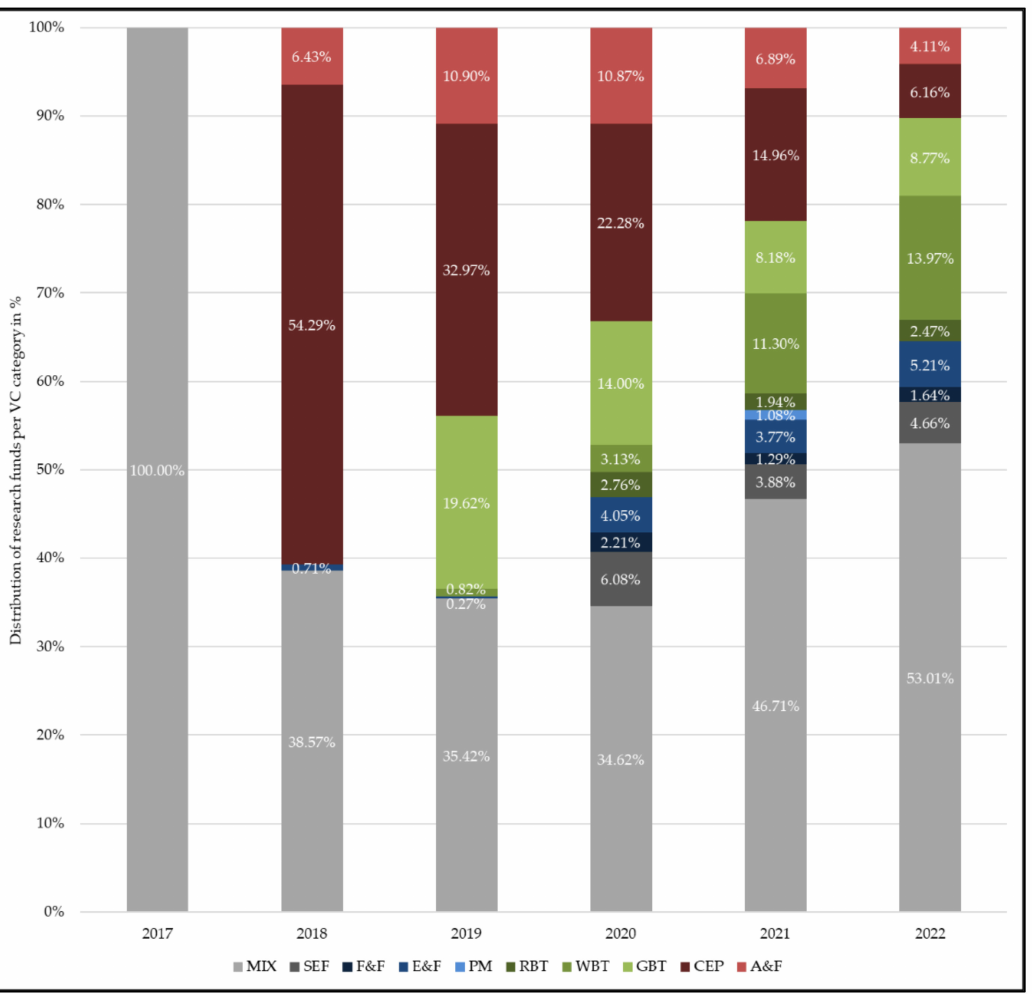
Figure 11. Proportional distribution of bioeconomic thematic focus of research collaborations in the period